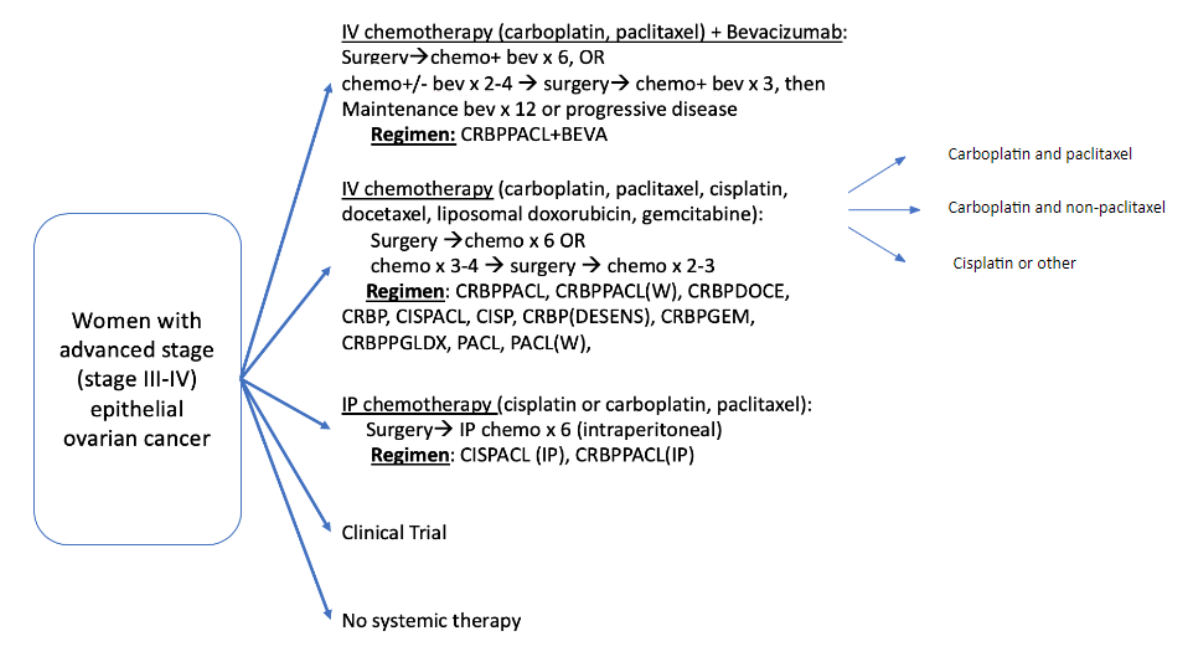
Figure A4. Identification of first-line regimen using ALR and NDFP.